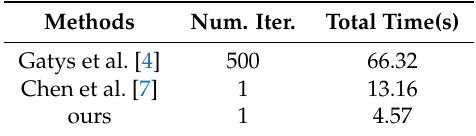
Table 1. Comparison of average computation